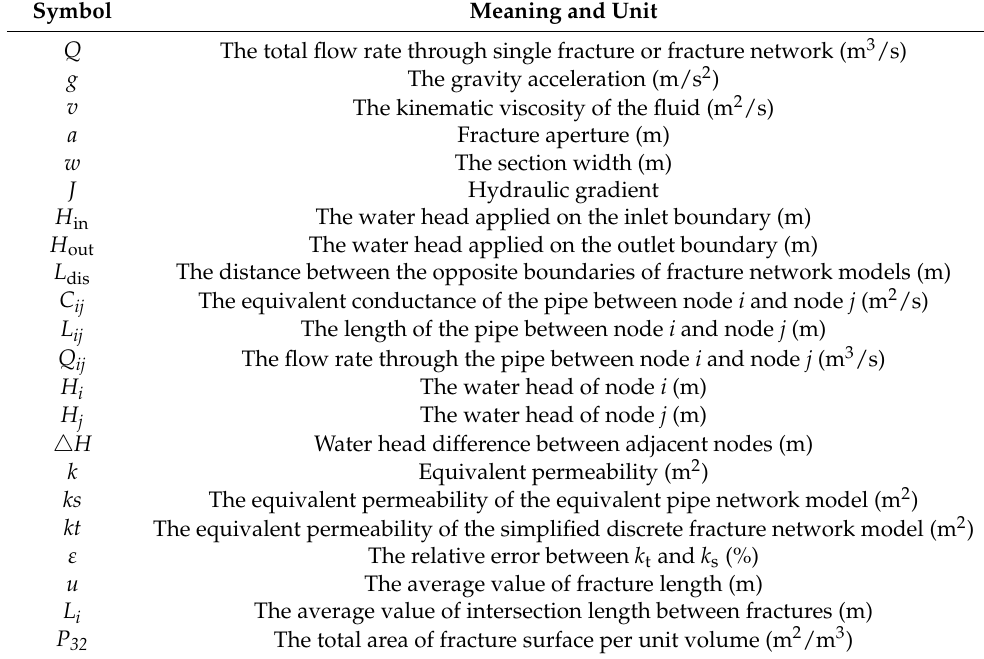
Table A1. The list of